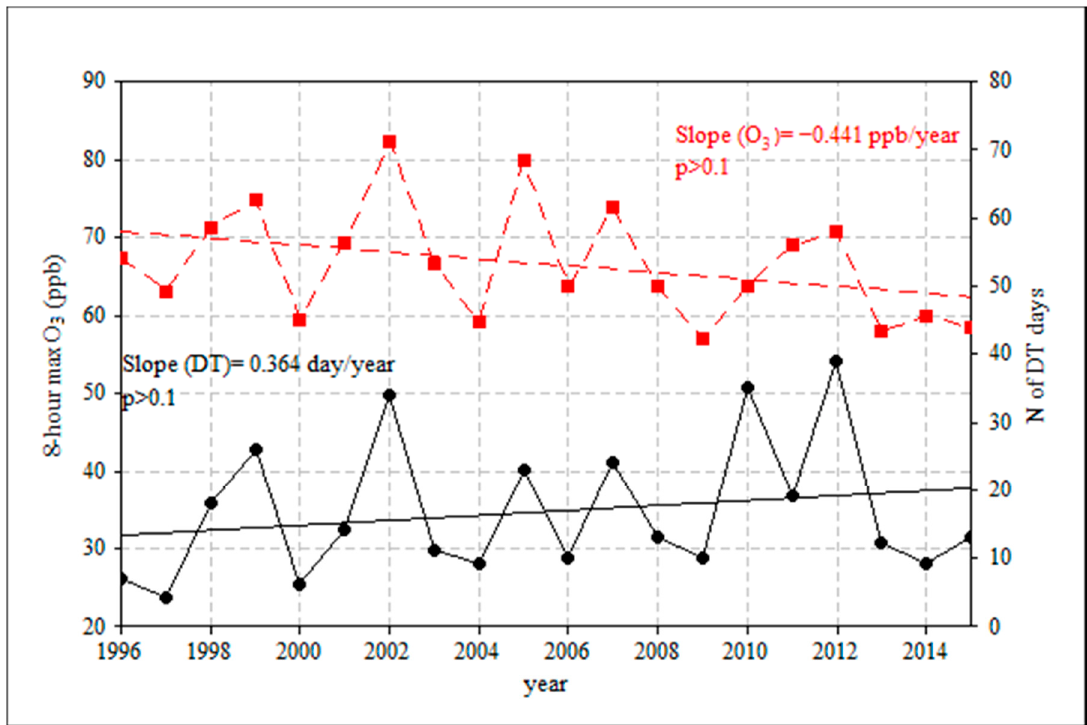
Figure 6. Smog season 90th percentile 8 h max O 3 concentrations in Windsor and the number of dry tropical (DT) days during 1996–2015.